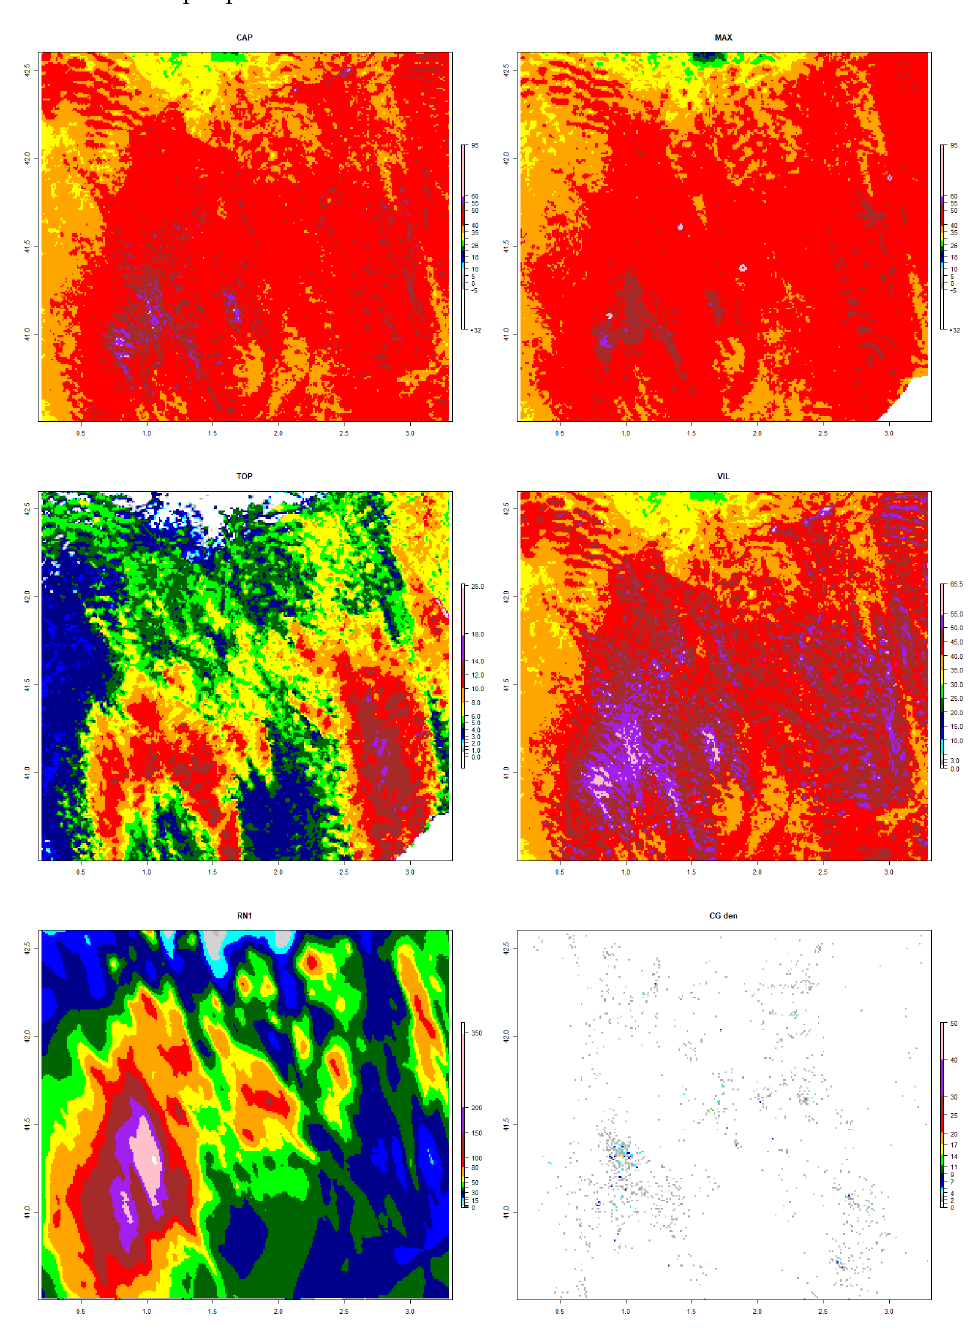
Figure 5. Daily maps of the different radar parameters (CAP, MAX, TOP, VIL, and RN1) and CG density for the day of 22 October